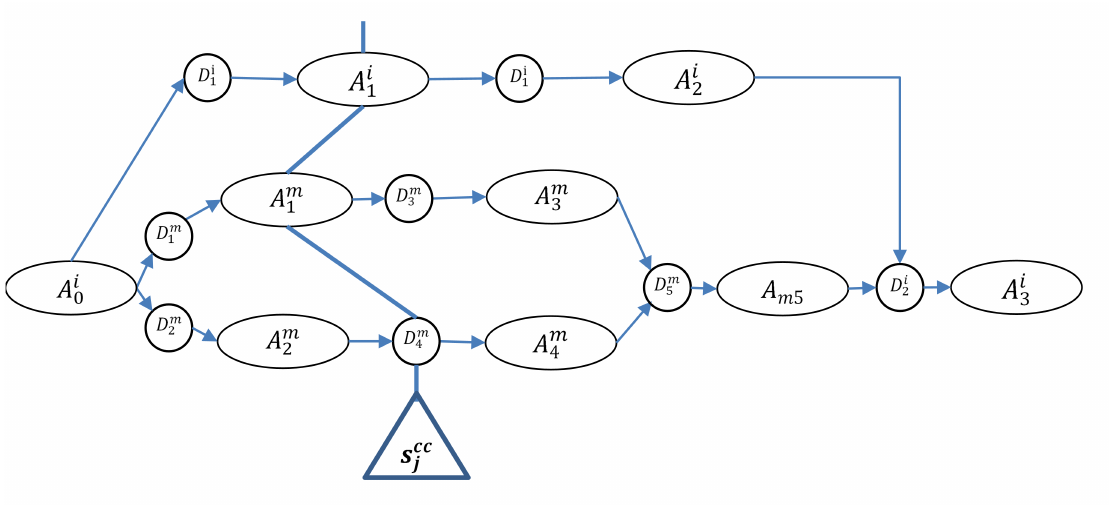
Figure 7. An example of